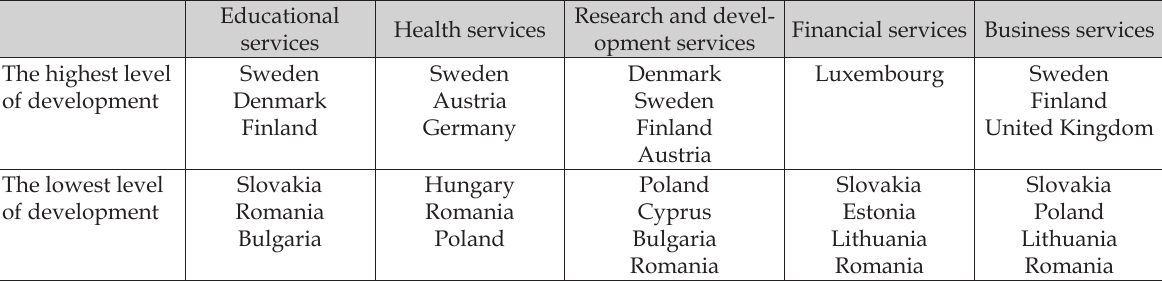
Table 2. Countries with the highest and lowest levels of development of selected modern services.